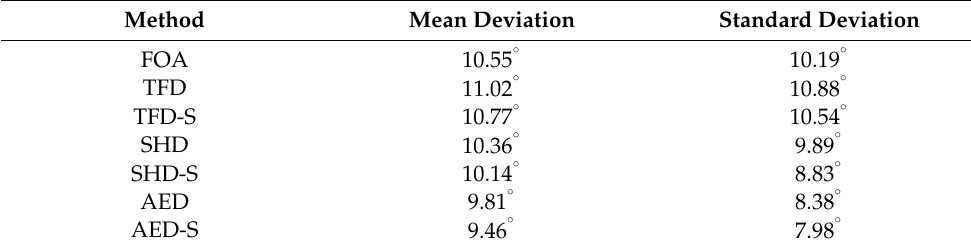
Table 5. Mean and standard deviation for the LOCATA